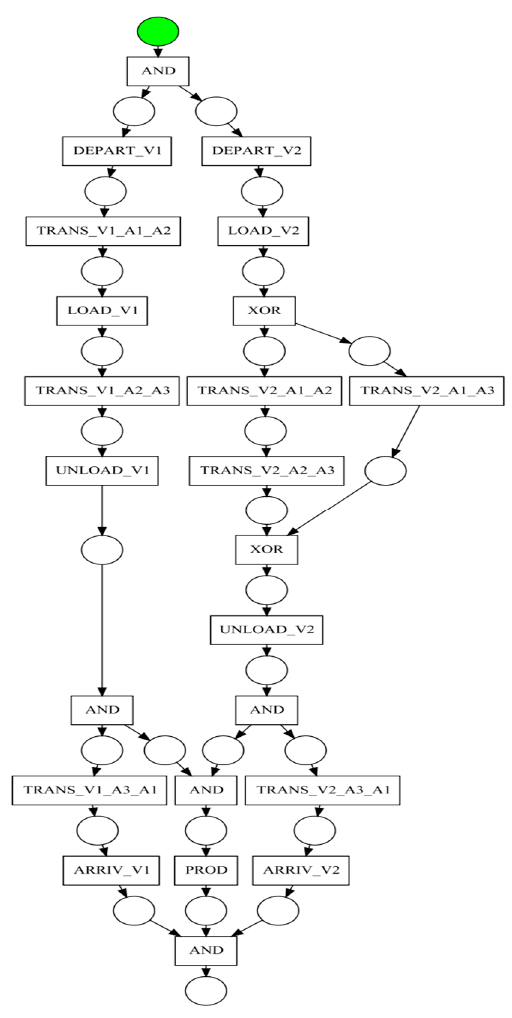
Figure 6. Process model of the proposed scenario.